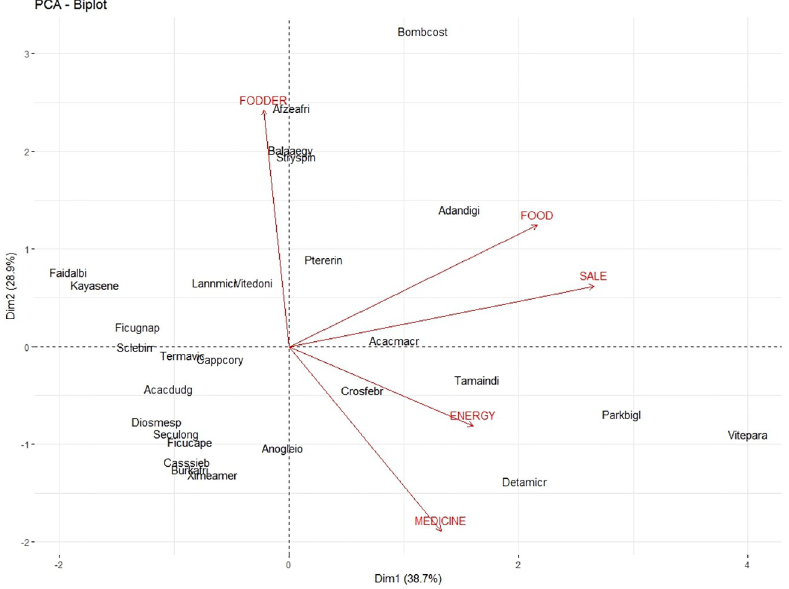
Fig 4. Biplot of the Principal Component Analysis assessing the relationship between woody species and attributes assigned by the four villages (Cassou, Dao, Kou and Vrassan) in Ziro province of Burkina Faso.